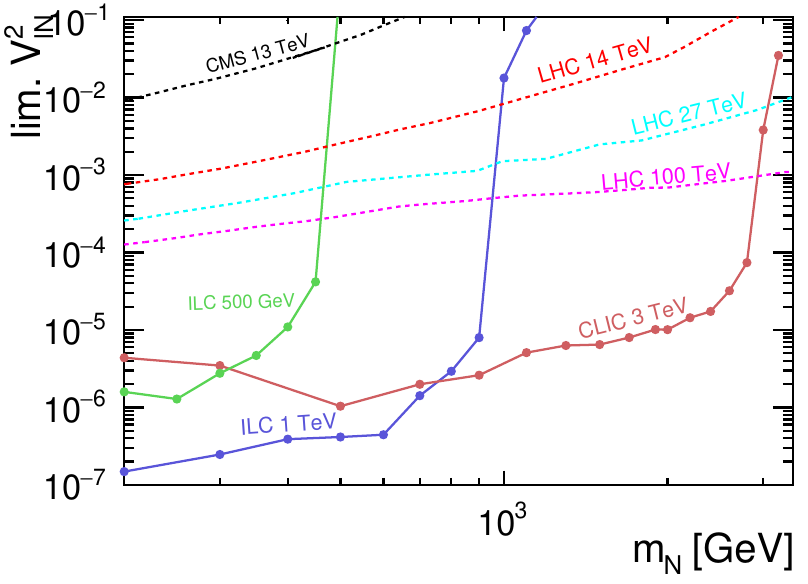
for different collider setups (solid lines: ILC500 — green, Figure 12. Limits on the coupling V 2 ‘N ILC1000 — violet, CLIC3000 — dark red). Dashed lines indicate limits from current and future hadron colliders based on [20, 24]. See the text for